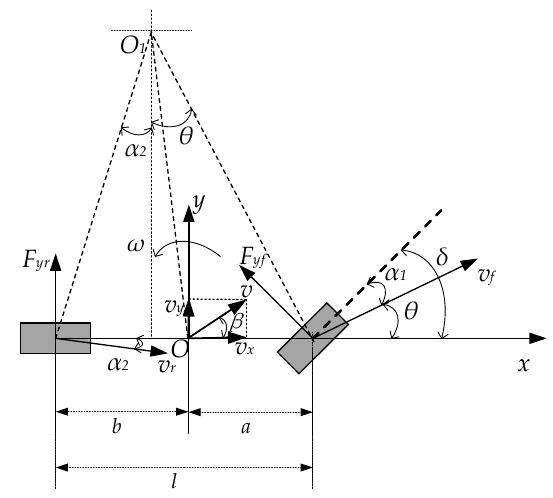
Figure 1. Vehicle two ‐ degree ‐ of ‐ freedom dynamics model.